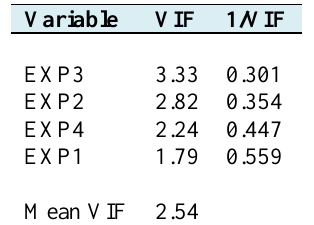
Table 4. Variance Inflation Factor